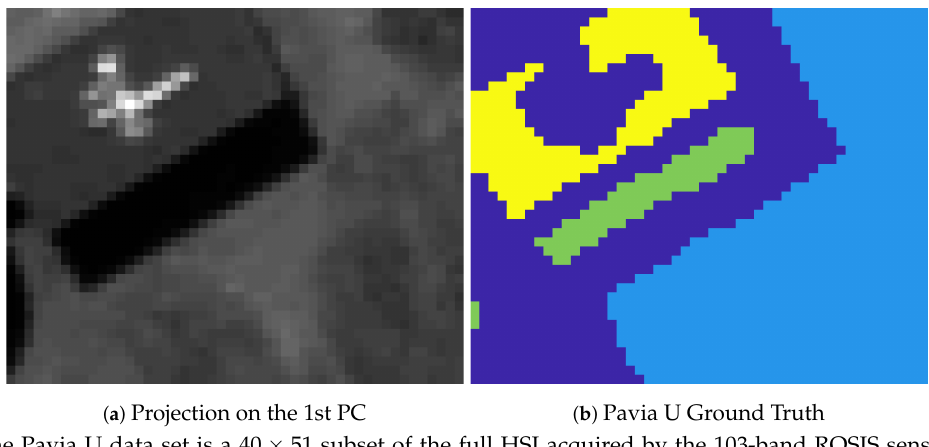
Figure 6. The Pavia U data set is a 40 × 51 subset of the full HSI acquired by the 103-band ROSIS sensor over Pavia University. There are 3 clusters in the ground truth. The projection onto the first principal component is in ( a ), the ground truth labels in ( b ). A spatial radius of r = 30 was used in